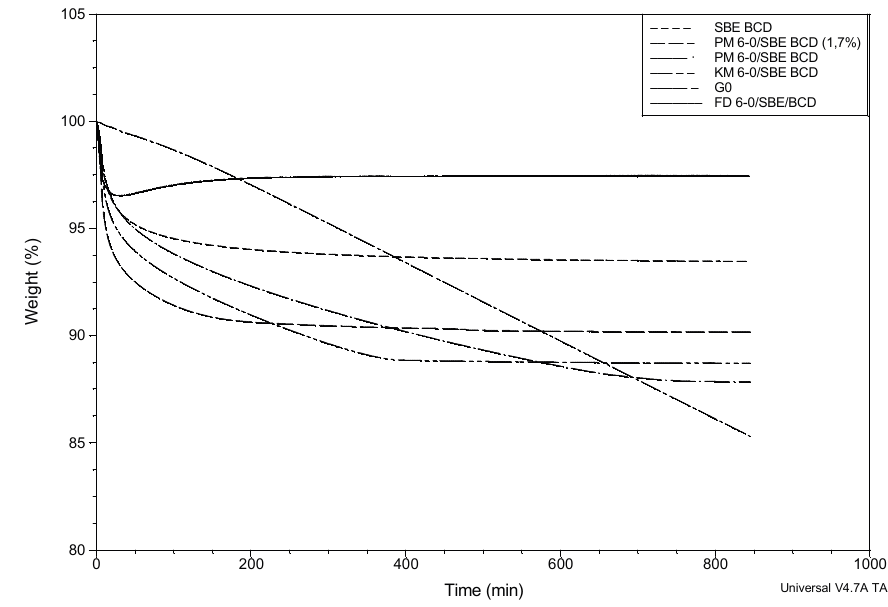
Figure 8. Isothermal time-dependent TGA curves of: pure G-0 (broken dash), SBE- β -CD (short dash), physical mixture (PM) G-0/SBE- β -CD (1.7%) (dash), physical mixture (PM) G-0/SBE- β -CD (7%) (dash dot), kneaded mixture (KM) G-0/SBE- β -CD (7%) (broken double dash) and freeze-dried (FD) G-0/SBE- β -CD (1.7%) (solid